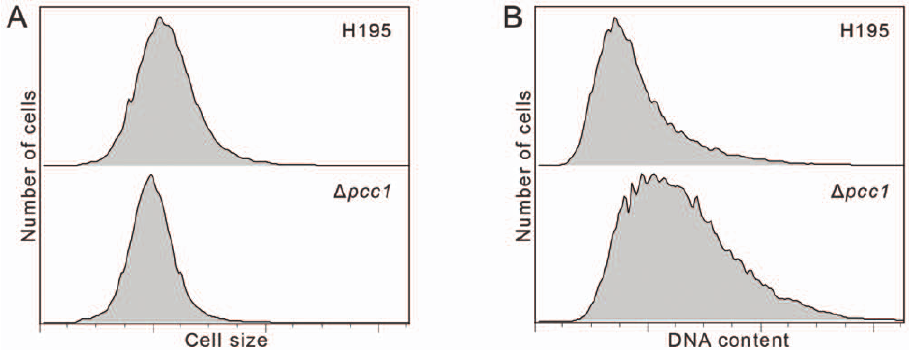
Figure 3. Flow cytometry analysis of Haloferaxvolcanii H195 and H133 D pcc1 mutant cells. H195 (based on H133, with a bga Ha-Bb deletion, and a leuB - Ag1 allele, which has flow cytometry profiles highly similar to H133– data not shown) A. Cell size as determined by forward light scatter of H195, and of D pcc1 (HAN16). B. Nucleic acid content as determined by acridine orange fluorescence of H195 (wild-type) and in D pcc1 (HAN16).